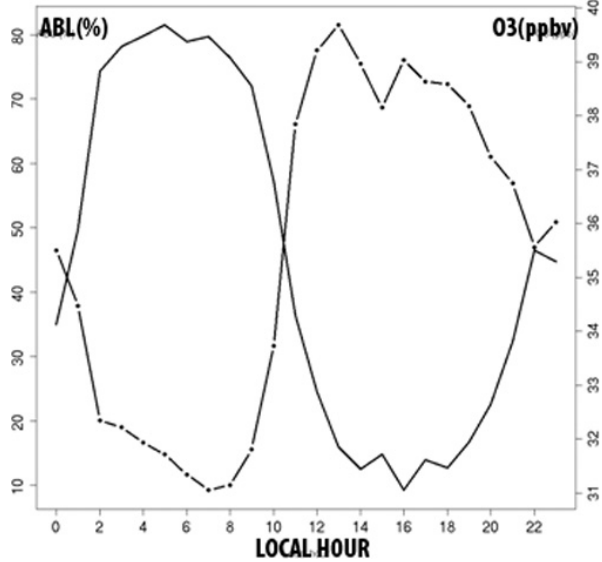
Fig. 11. Diurnal variation of the concentrations in ABL tracer (in percent of the concentration in the ABL, dashed line) and in O 3 - tracer (solid line, in ppbv) in simulation